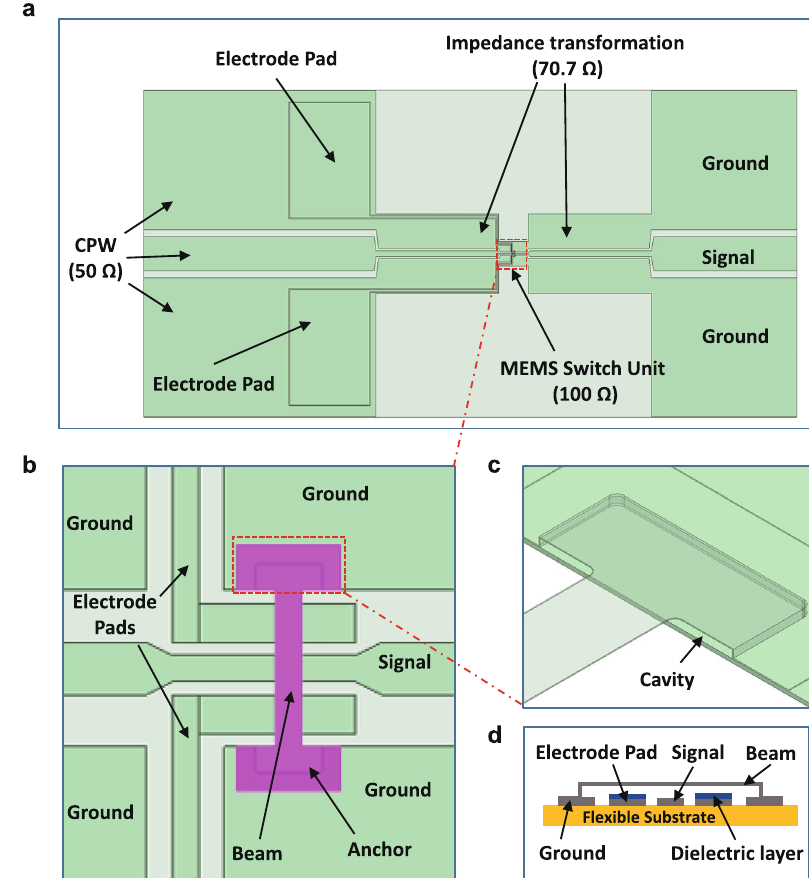
Fig. 2 Flexible RF MEMS switch design for characterization. a Design of RF MEMS switch including test port and impedance transformation. b Partial enlarged view of RF MEMS switch unit design. c Anchor structural design of three-side support cavity. d Side view of schematic diagram of RF MEMS